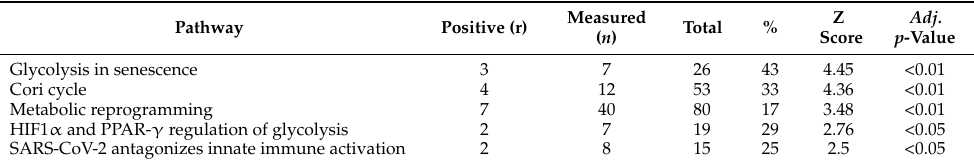
Table 4. Pathways overlapped in OTA exposure (100 nM) by PathVisio.